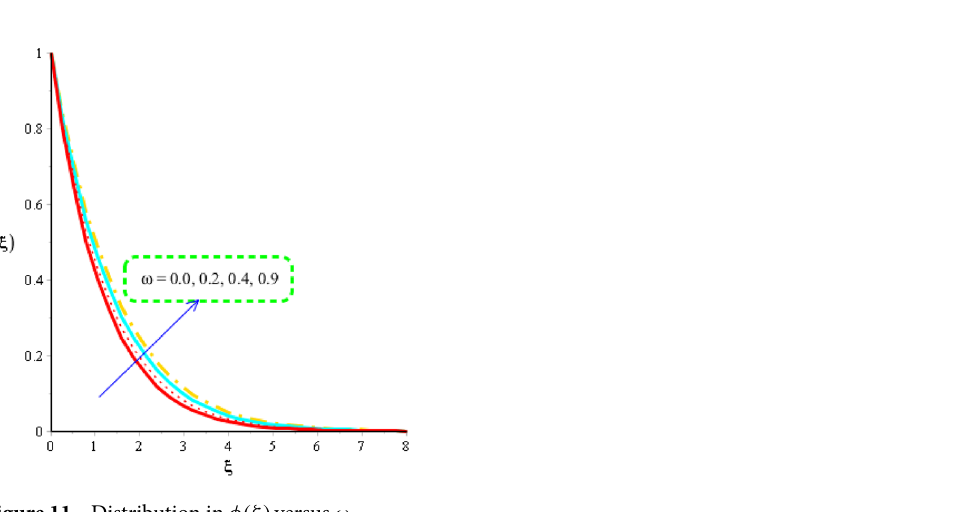
Figure 11. Distribution in φ(ξ) versus ω .